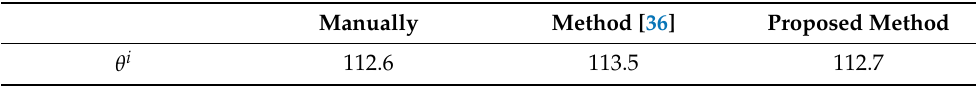
Table 5. Inclination of the PV module considering several